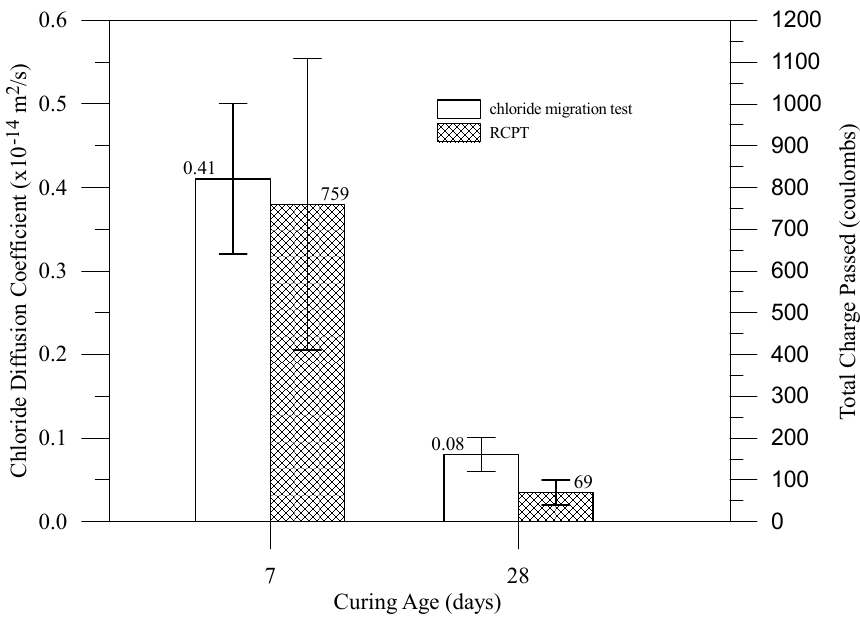
Figure 10. The results of the chloride migration test and